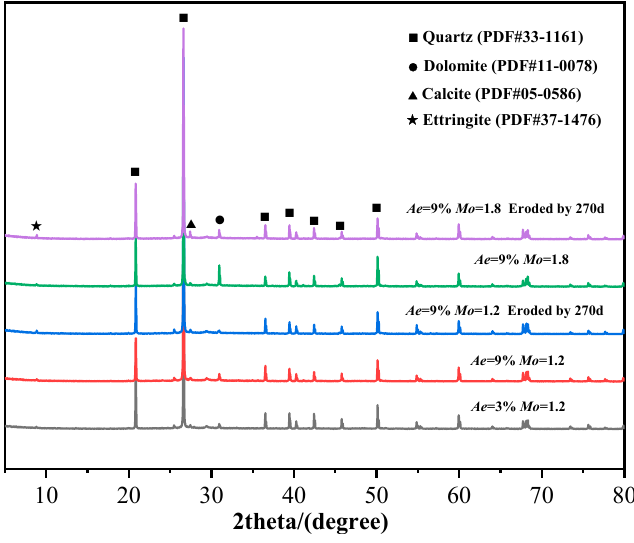
Figure 5. XRD patterns of GPM specimens.